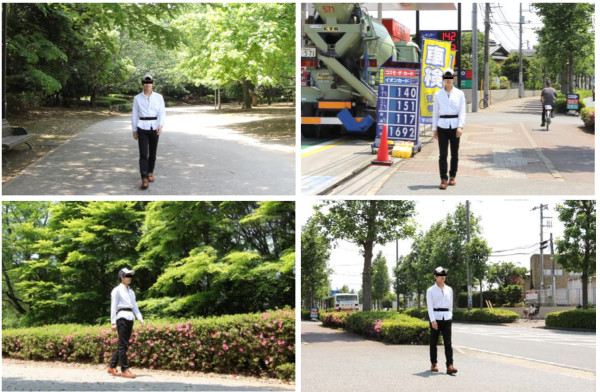
Experimental sites.